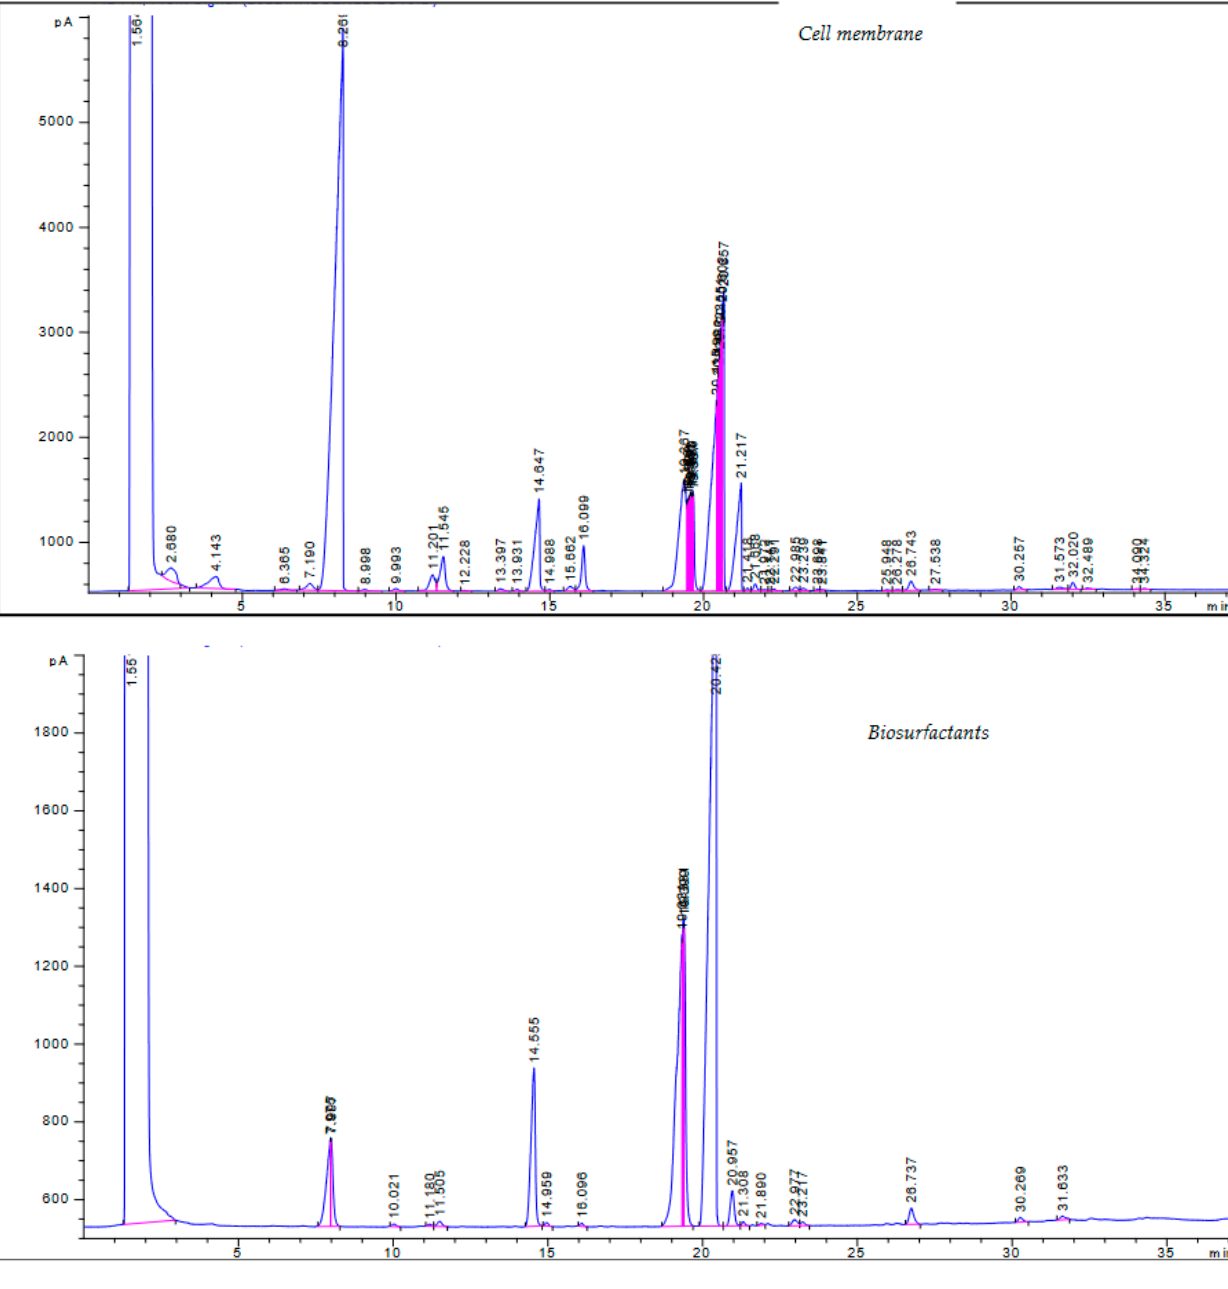
Figure 6. Chromatogram profiles of cell membrane and fatty acid compositions of biosurfactants of Pantoea alhagi strain Zcb15.